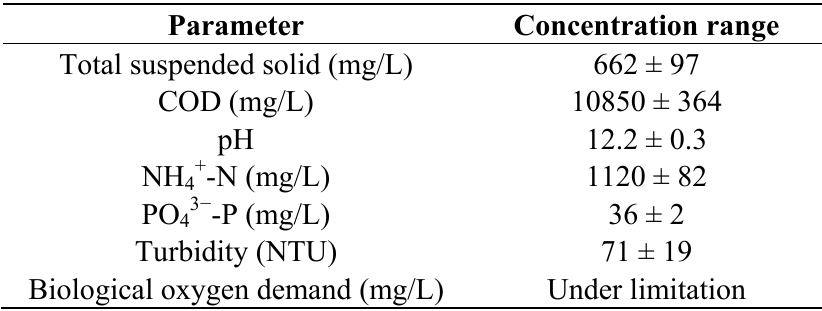
Table 2. Characteristics of 7-ACA